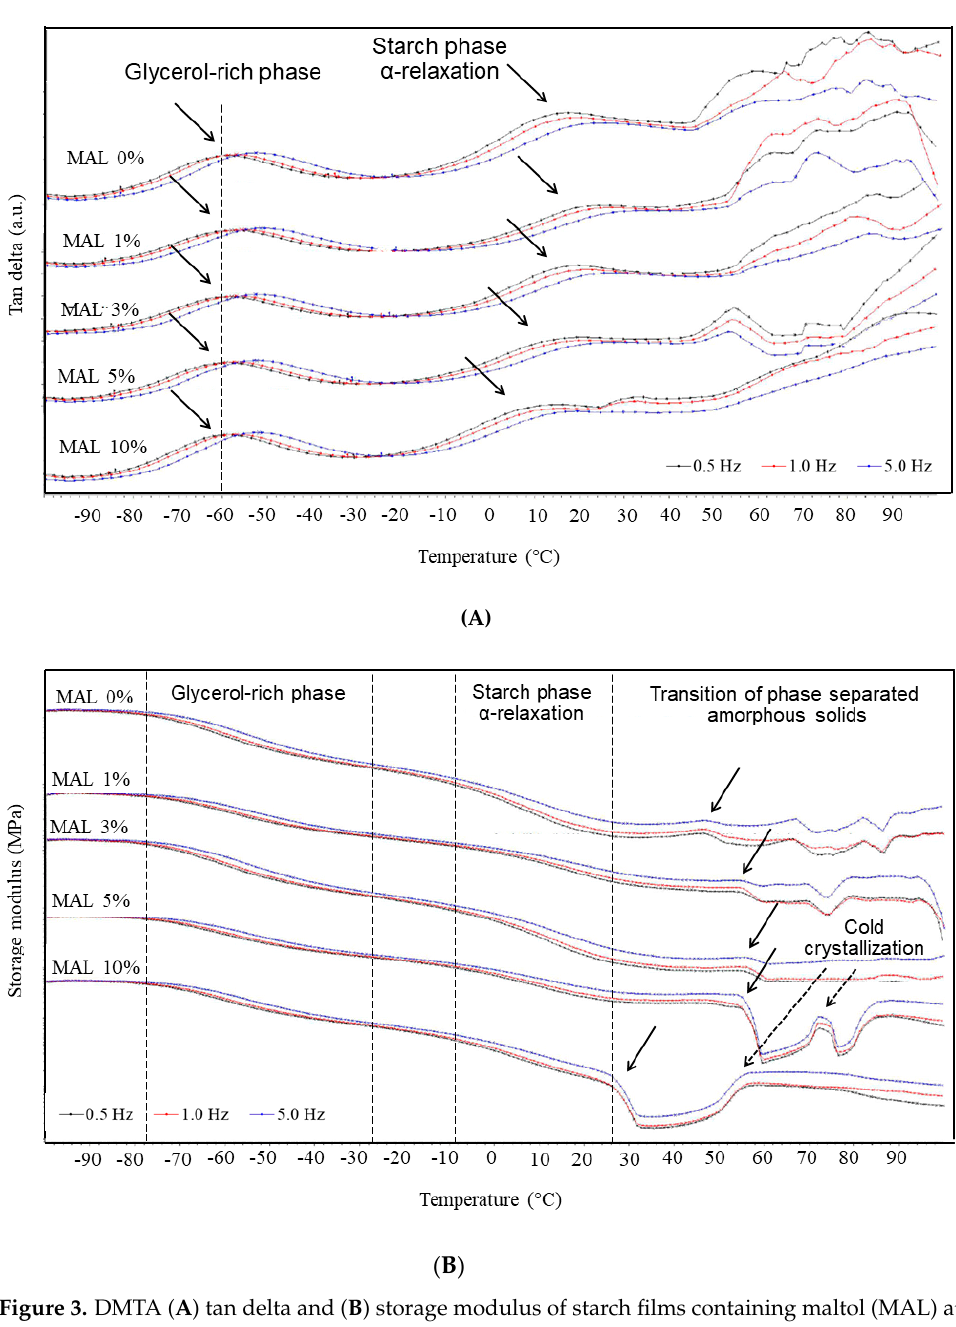
Figure 3. DMTA ( A ) tan delta and ( B ) storage modulus of starch films containing maltol (MAL) at 0, 1, 3, 5 and 10%.